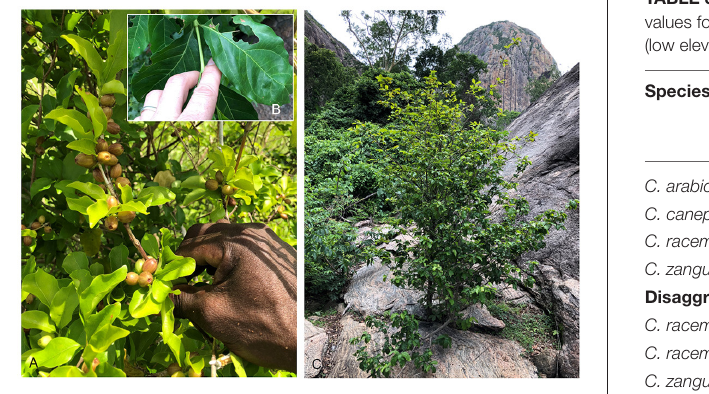
FIGURE 5 | Coffea zanguebariae. (A) Shoots of a cultivated plant, with immature fruits and ripening fruits (red), cultivated near Pema, north-eastern Mozambique; (B) Leaves of a wild plants, for size comparison; (C) Habit of wild plant. (B,C) images taken at Taratibu, near Metoro, near Pemba, north-eastern Mozambique (images: Aaron Davis).